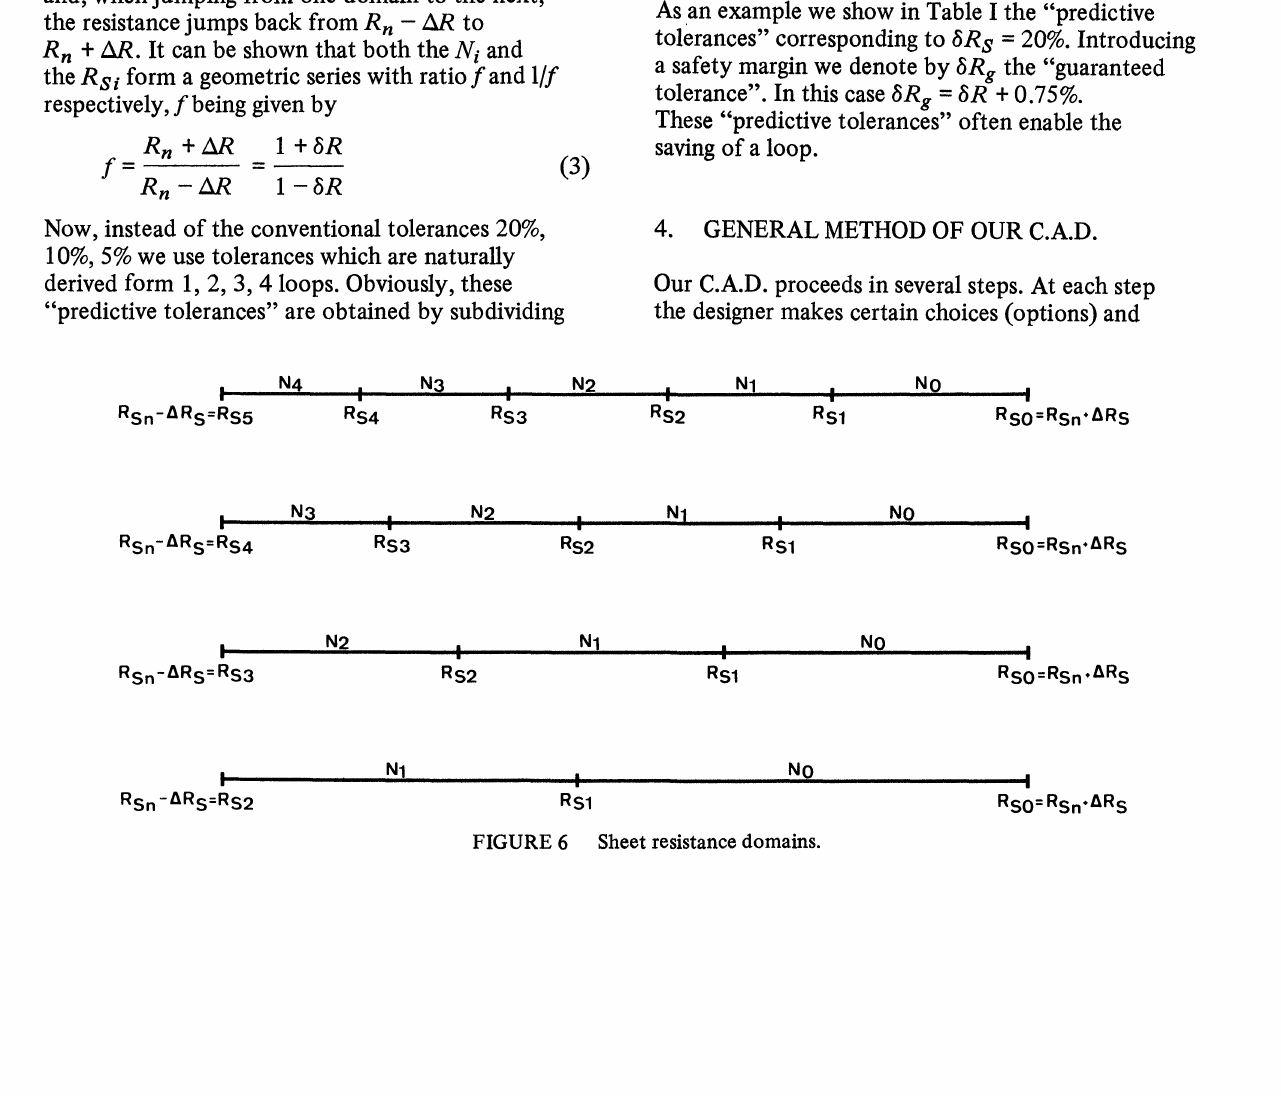
FIGURE 6 Sheet resistance